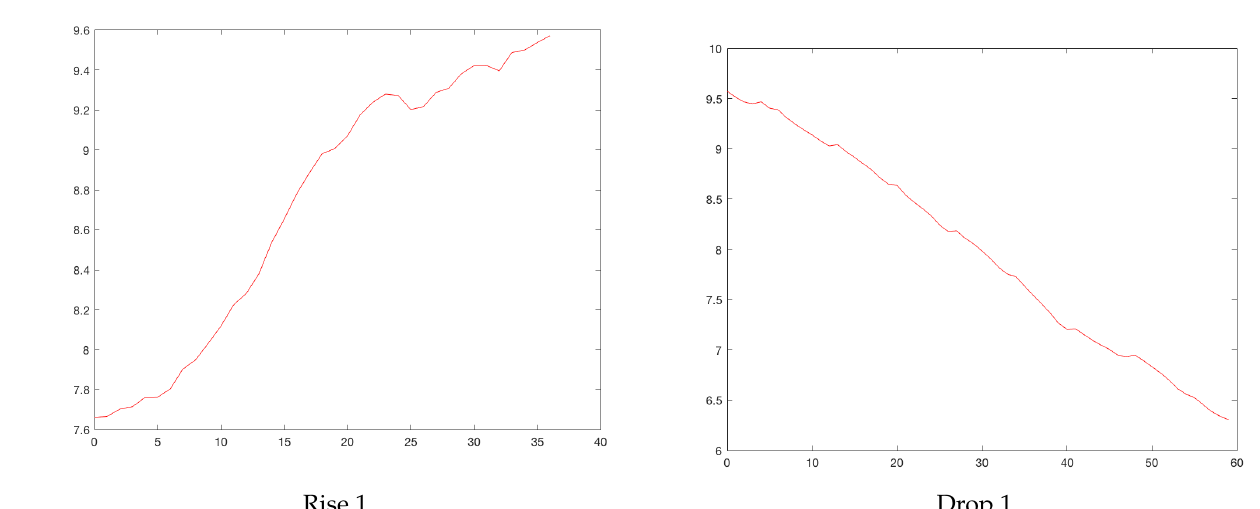
Figure A8. London’s rise and drop. Horizontal axis, days; vertical axis: logarithm of daily